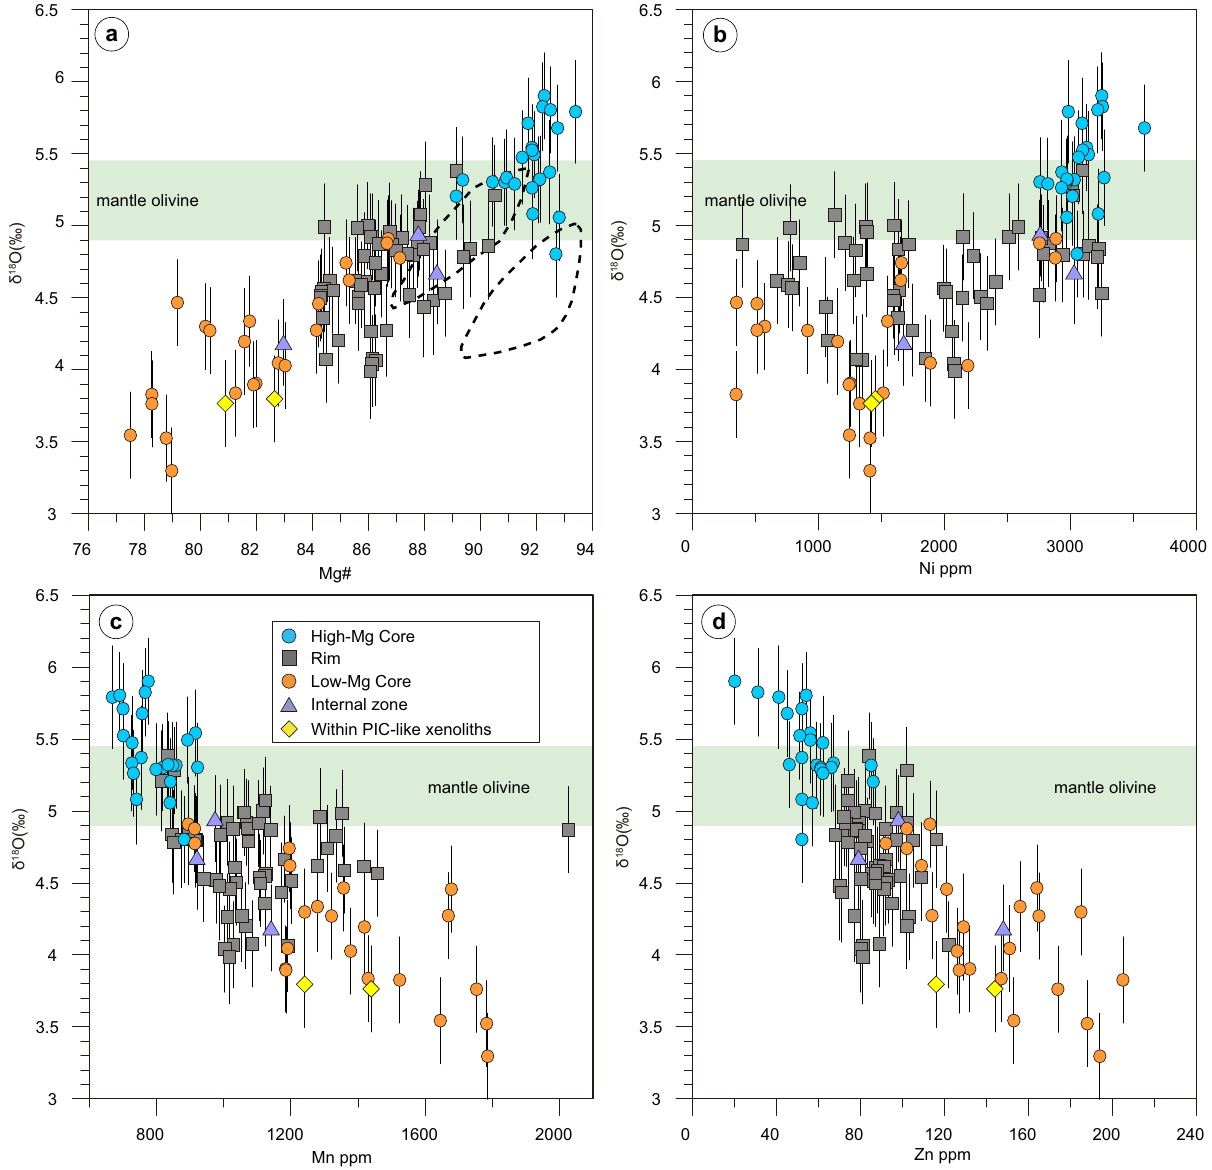
Fig. 5 δ 18 O-Mg#-Ni-Mn-Zn covariation diagrams for olivine grains. Covariation diagrams of δ 18 O versus a Mg#, b Ni (ppm), c Mn (ppm), and d Zn (ppm) for olivine in the examined southern African kimberlites. Two dashed outlines show olivine compositions from two Kimberley polymict breccia xenoliths (i.e., failed kimberlite magmas at mantle depths) 48 . Green bands represent the mantle olivine value (5.18 ± 0.28 ‰ ; see ref. 3 ). Error bars indicate the 2 σ of each